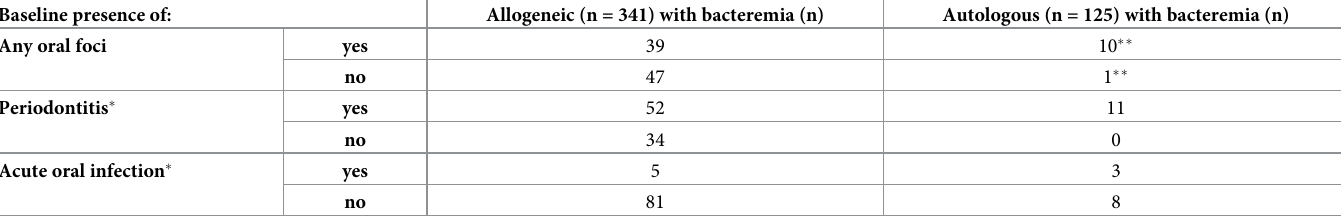
Table 4. Association of having oral foci of infection with blood culture positive bacteremia within six months post-HSCT. Baseline presence